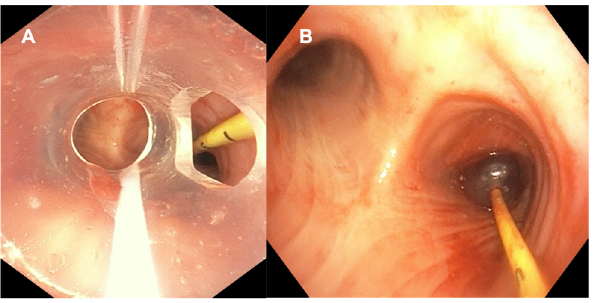
Figure 3. Using RFB for Management Hemoptysis. These figures illustrate high-quality images of the endobronchial blocker next to the endotracheal tube ( A ) and isolating the bronchus intermedius ( B ) using RFB (Olympus P 190 bronchoscope).